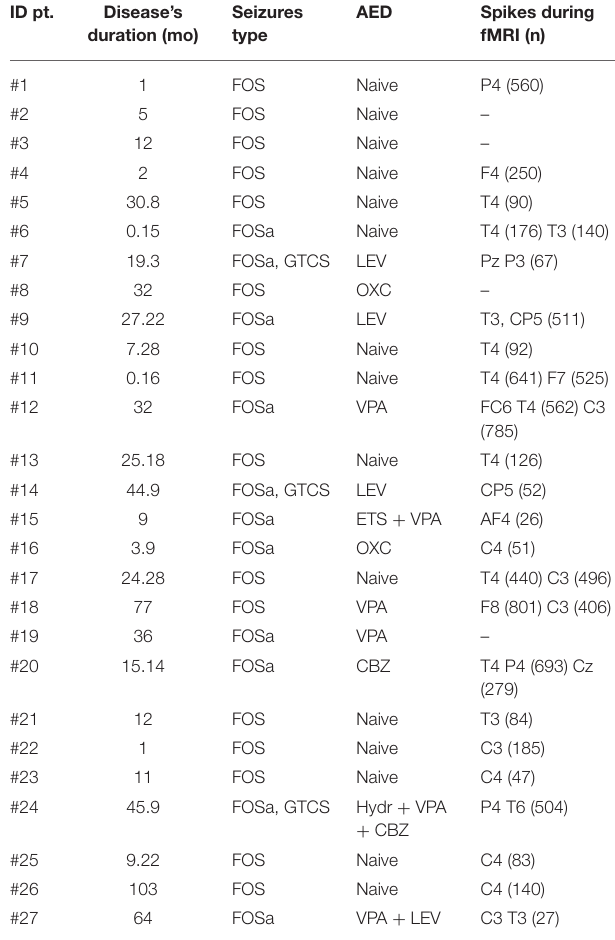
TABLE 1 | Demographic and electroclinical data of